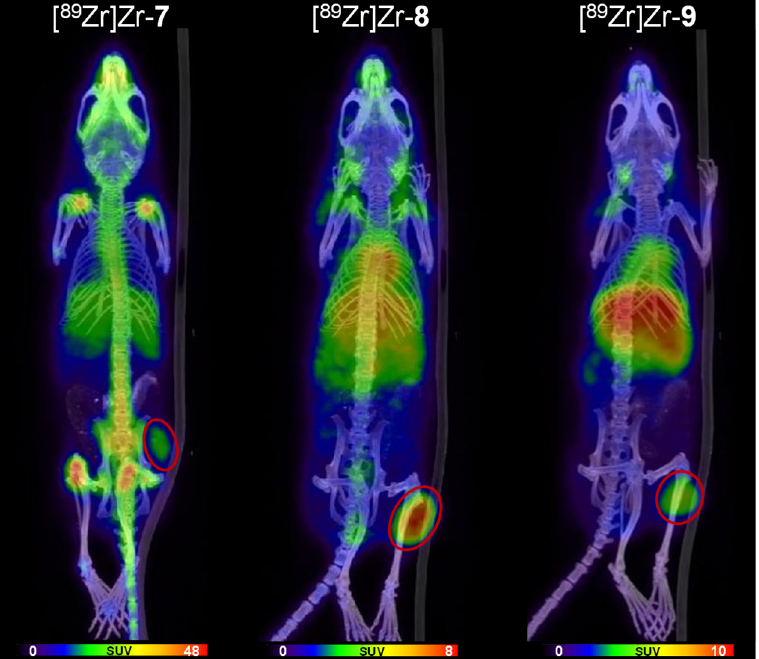
Figure 6. Representative small animal positron emission tomography/computed tomography (PET/CT) images obtained for [ 89 Zr]Zr-DFO-cetuximab ([ 89 Zr]Zr- 7 ), [ 89 Zr]Zr-DFO*-cetuximab ([ 89 Zr]Zr- 8 ) and [ 89 Zr]Zr-3,4,3-(LI-1,2-HOPO)-cetuximab ([ 89 Zr]Zr- 9 ) in HT-29 tumor-bearing xenograft nude mice. The images show maximum intensity projections (MIPs) of the whole animals at 144 h post injection and the tumors are encircled.